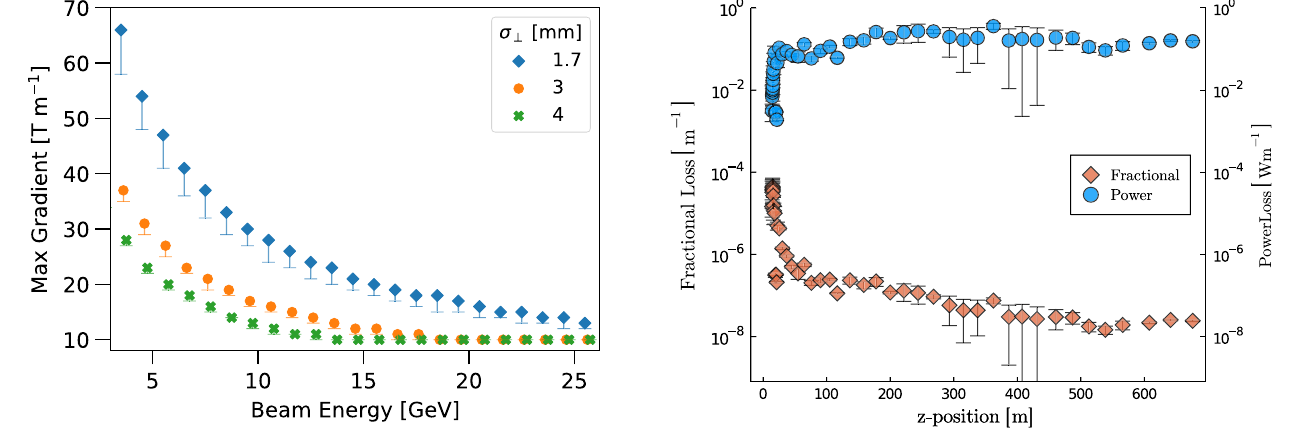
FIG. 3. Maximum quadrupole field gradients for maintaining a Lorentz stripping beam-power loss rate of less than 0.1 W/m as a function of beam energy in GeV. A radial Gaussian distribution is used, with error bars reflecting a μ ¼ 0 . 7 mm offset, see Eqs. (6) and (9).